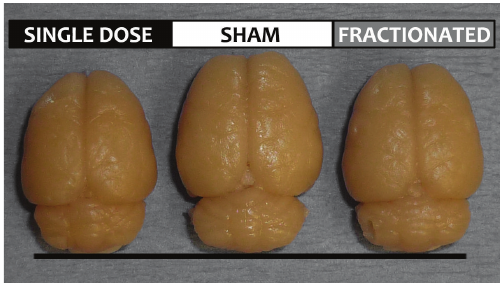
Figure 1: Irradiation of the developing (PND28) rat brain results in visibly decreased brain size in adulthood. Note that a 20Gy total dose of X-ray radiation resulted in a smaller brain when it was administeredasasingledose.Afractionateddose(4 Gy/dfor5days) was less detrimental to brain